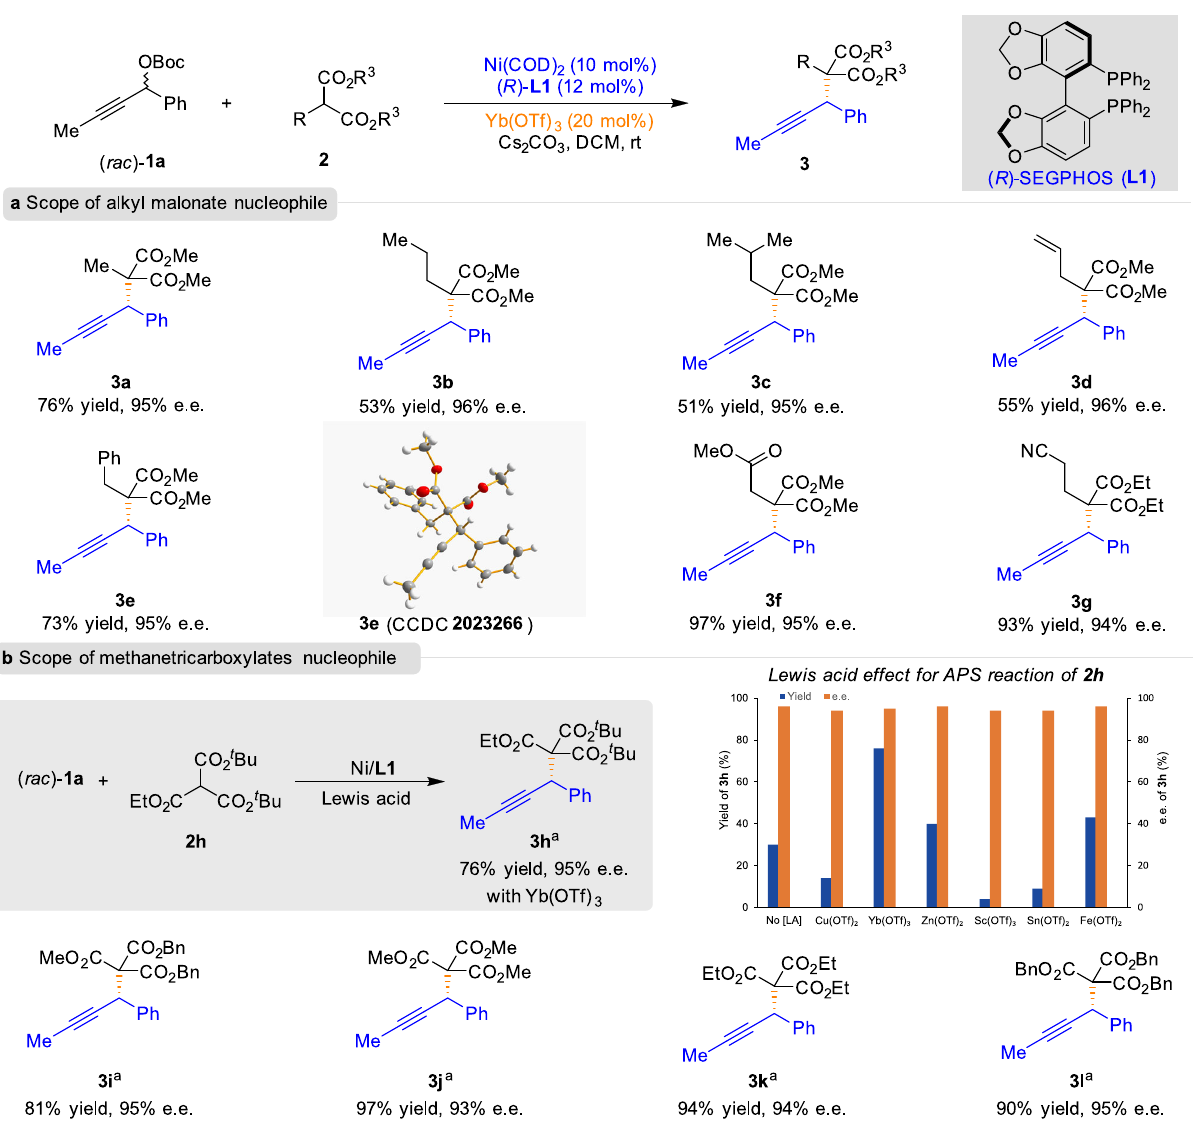
Fig. 2 Substrate scope of malonate esters. a Scope of alkyl malonate nucleophile. b Scope of methanetricarboxylates nucleophile. Unless otherwise noted, reactions were conducted with 1a (0.225 mmol), 2 (0.15 mmol), Ni(COD) 2 (10 mol%), ( R )- L1 (12 mol%), and Yb(OTf) 3 (20 mol%) in DCM (2.0 mL) at room temperature for 72 h. a In toluene (2.0